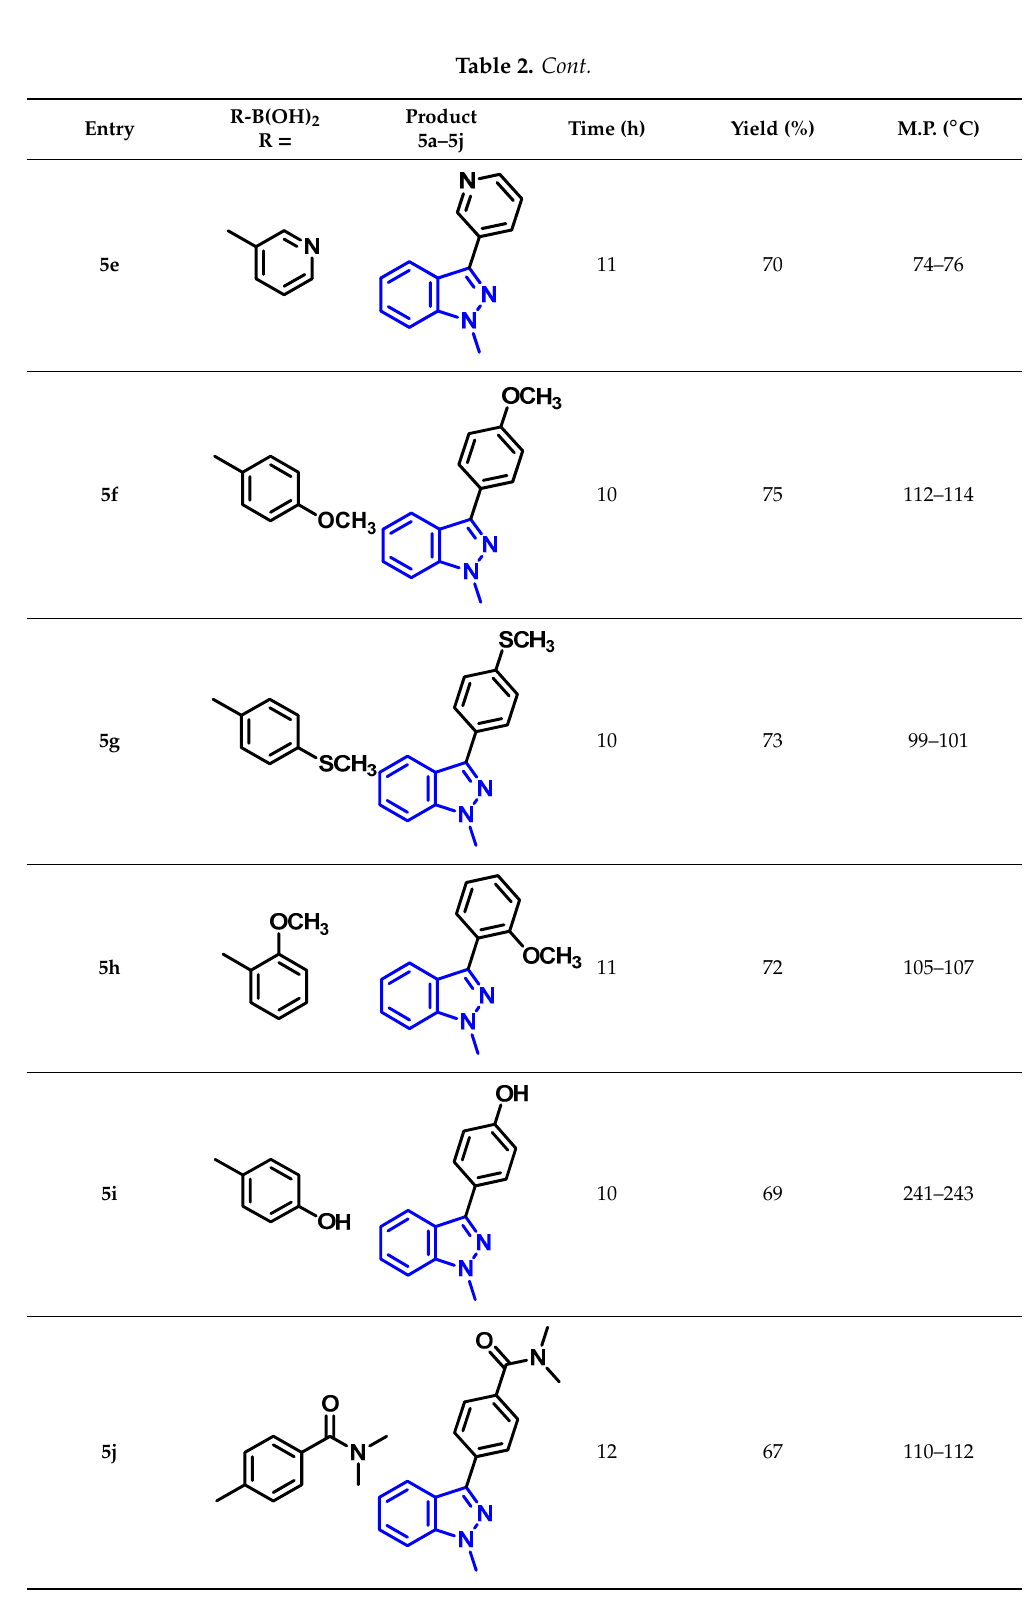
Table 2. Details of the series of compounds 5a–5j.